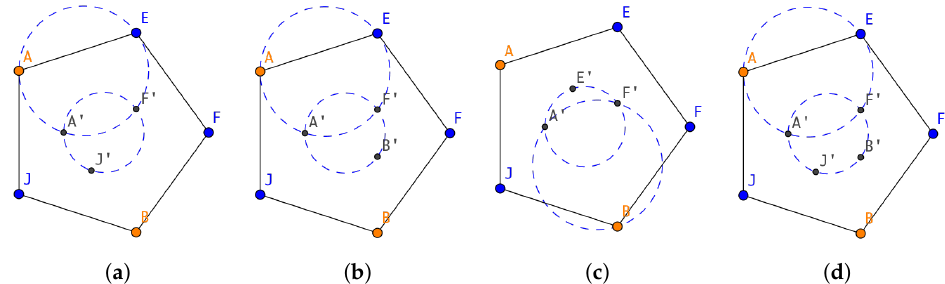
Figure 5. Insertion of the next 2 points into the pentagon. ( a ) insert J (cid:48) as the 3rd point; ( b ) insert F (cid:48) as the 3rd point; ( c ) insert E (cid:48) as the 3rd point; ( d ) insert the 4th